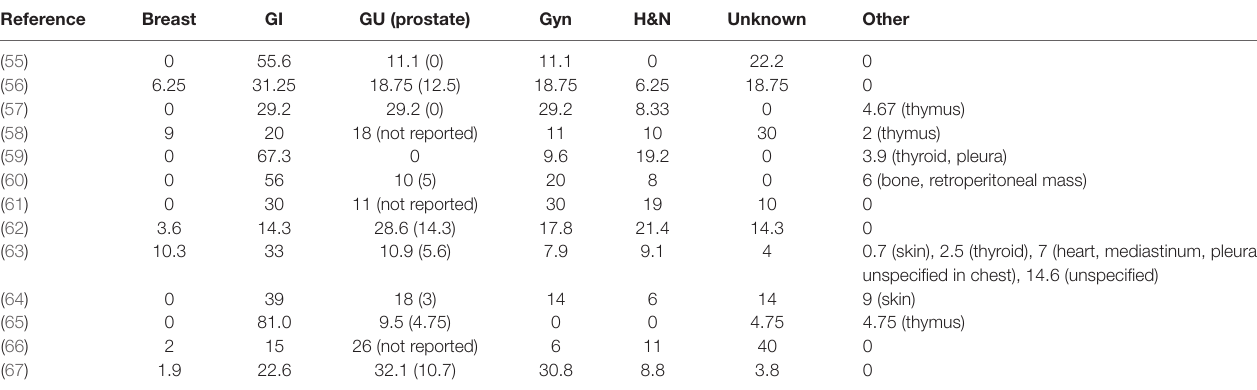
taBle 1 | Extrapulmonary small cell carcinoma: % frequency of sites of origin.